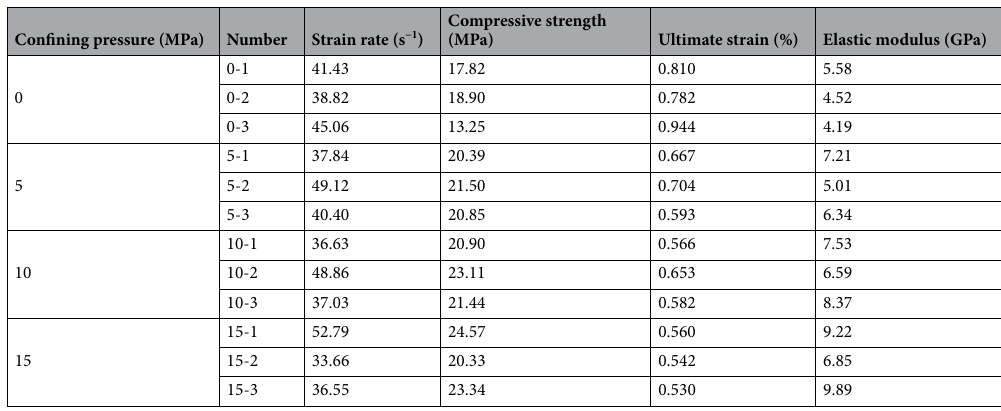
Table 5. Dynamic parameters of combined bodies under different confining